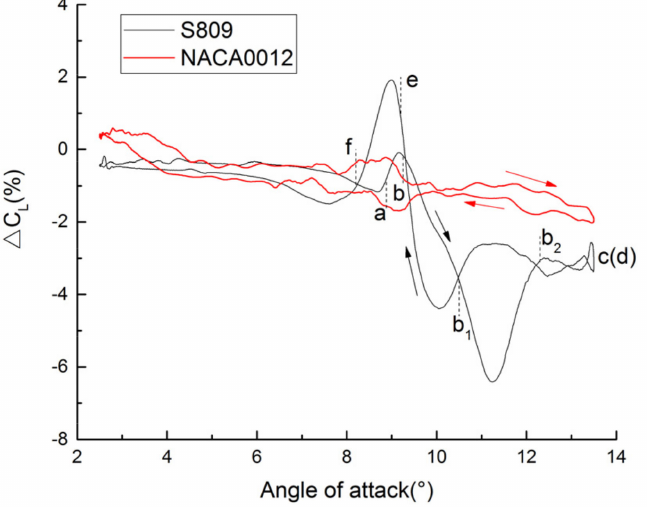
Figure 7. Relative increment loops of two airfoils after loading particles with a concentration of